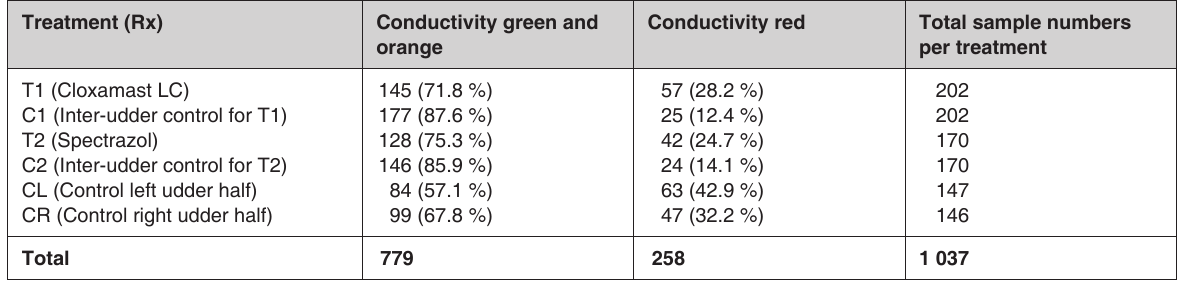
TABLE 2 Conductivity readings (colour code) for milk samples from milk goats for the treatment groups compared to those for the control groups Treatment (Rx)